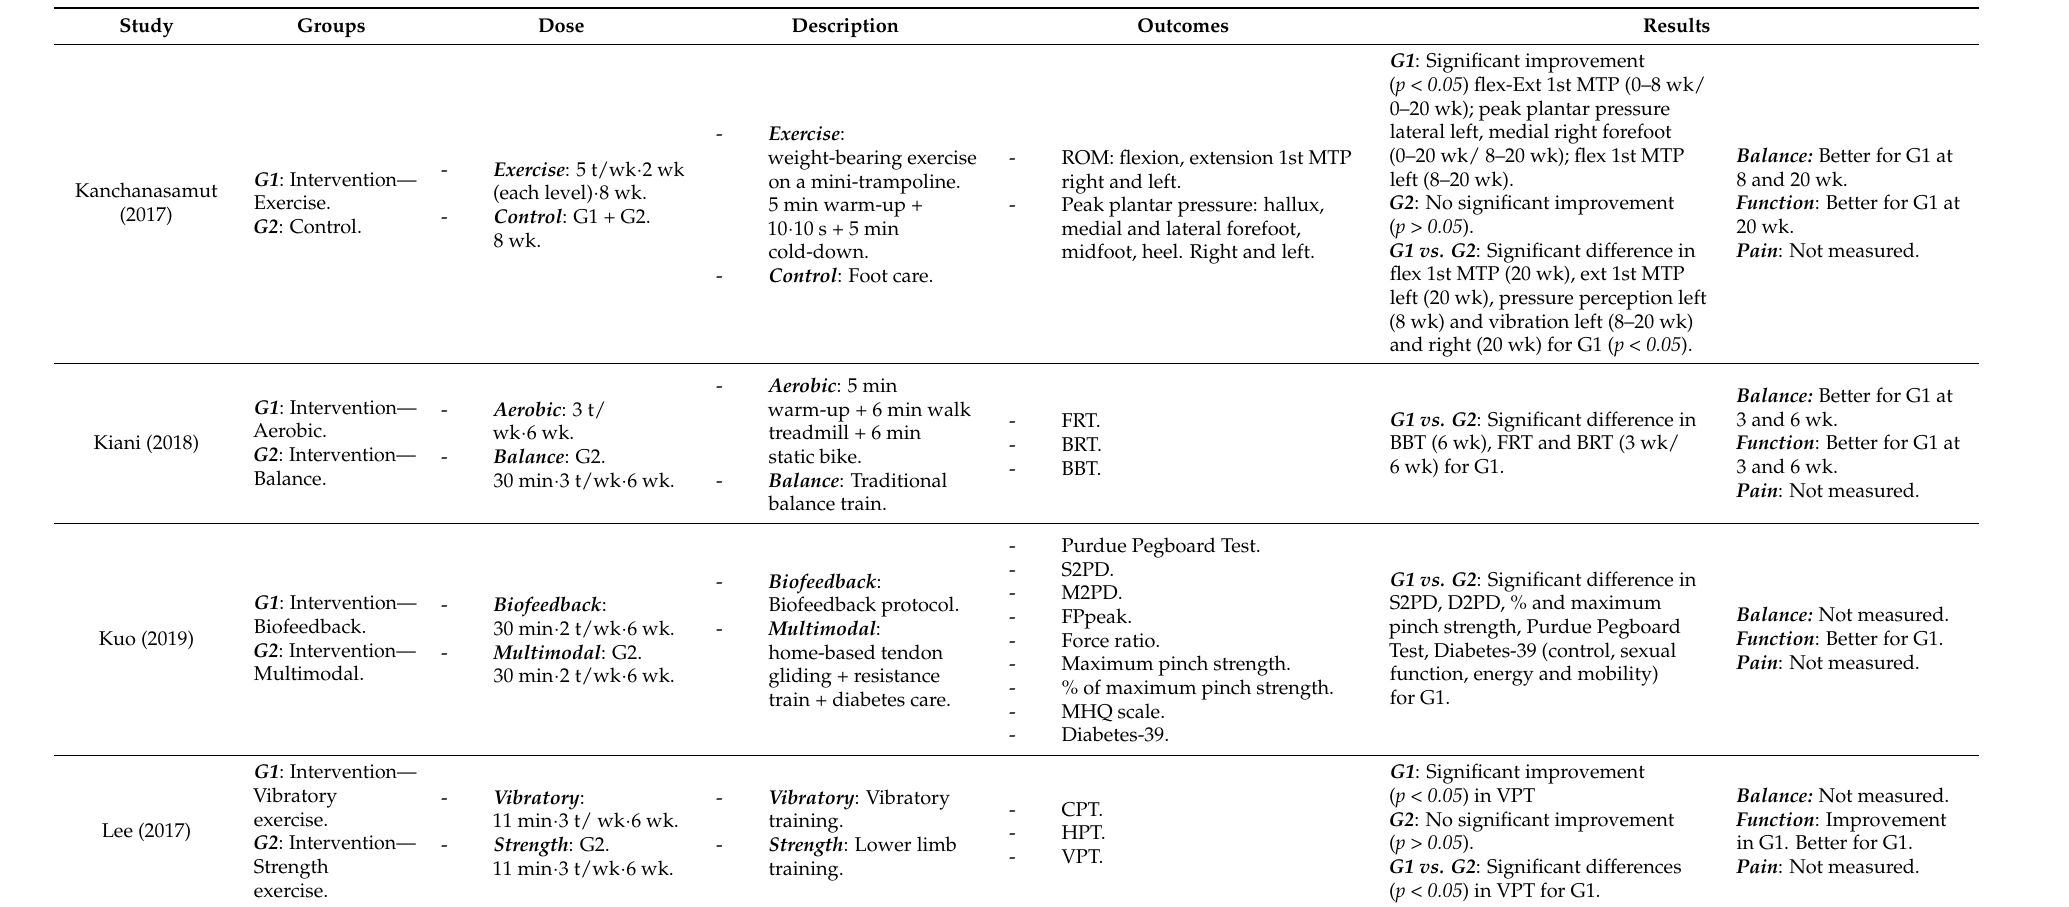
Description Outcomes